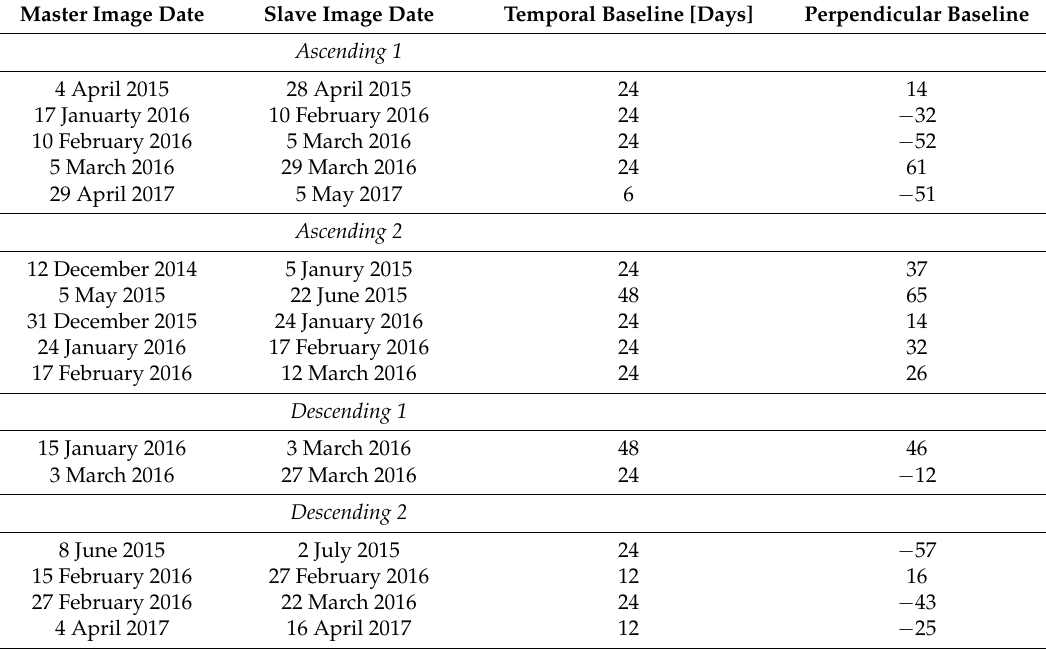
Table 2. Generated interferometric